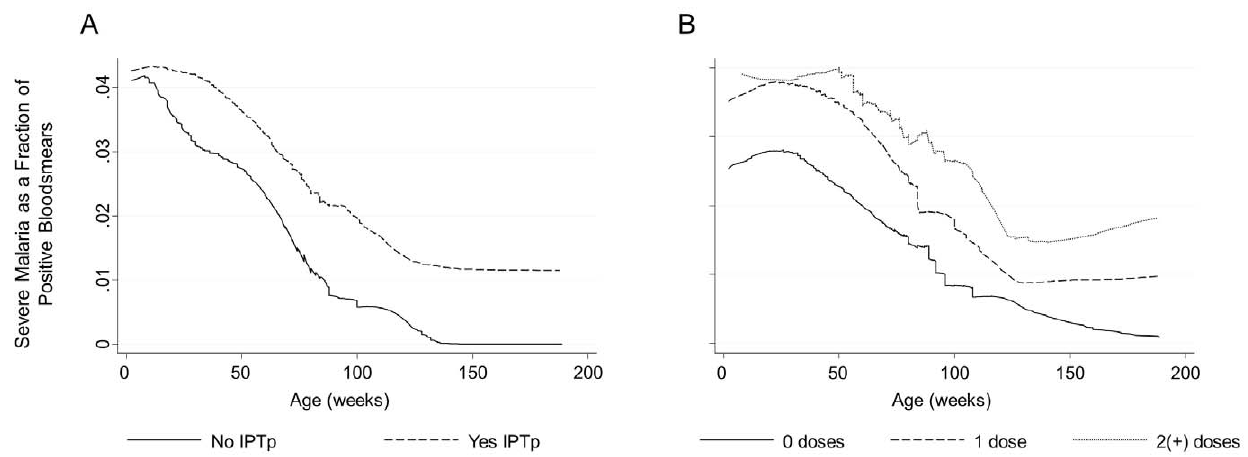
Figure 3. IPTp is associated with increased overall odds of severe malaria. Severe malaria as a fraction of positive bloodsmears by age of the child and maternal IPTp status (A) or dose (B), bandwidth one week. 1 dose: AOR=1.43, p=0.4 [95%CI: 0.62, 3.30]; 2( + ) doses: AOR=2.81, p=0.008 [95%CI: 1.31, 6.01].